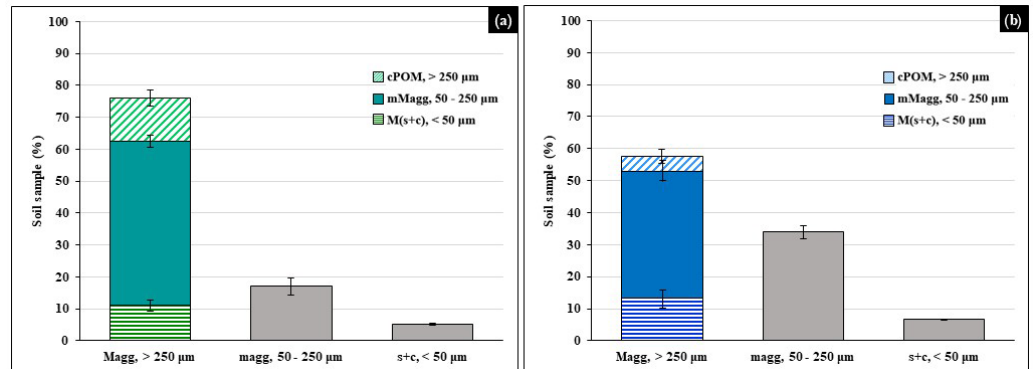
Figure 3. Size distribution of stable aggregates and individual particles in the soil under OPM (a) and CM (b) . Magg: Macroaggregates; magg: microaggregates; mMagg: microaggregates within macroaggregates; s + c : silt + clay fraction; cPOM: coarse particulate organic matter > 250µm and sand particles. The error bars represent the standard error, which is the standard deviation divided by the square root of the sample size. All aggregate fractions are significantly different ( p < 0 . 05) between OPM and CM, with the exception of